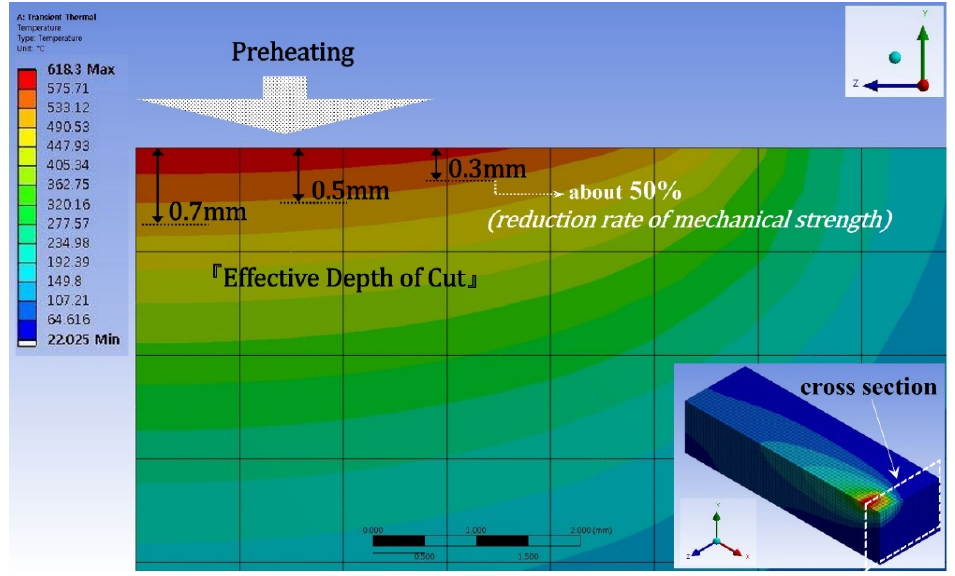
Figure 6. The results of the thermal analysis.